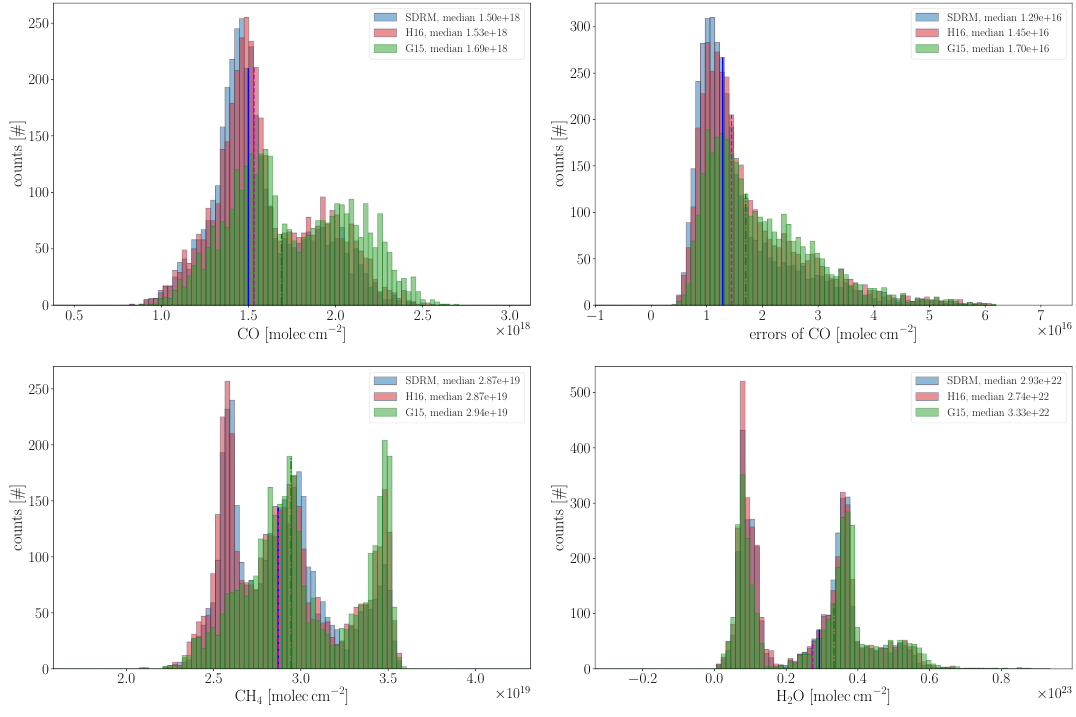
Figure 14. Distributions over